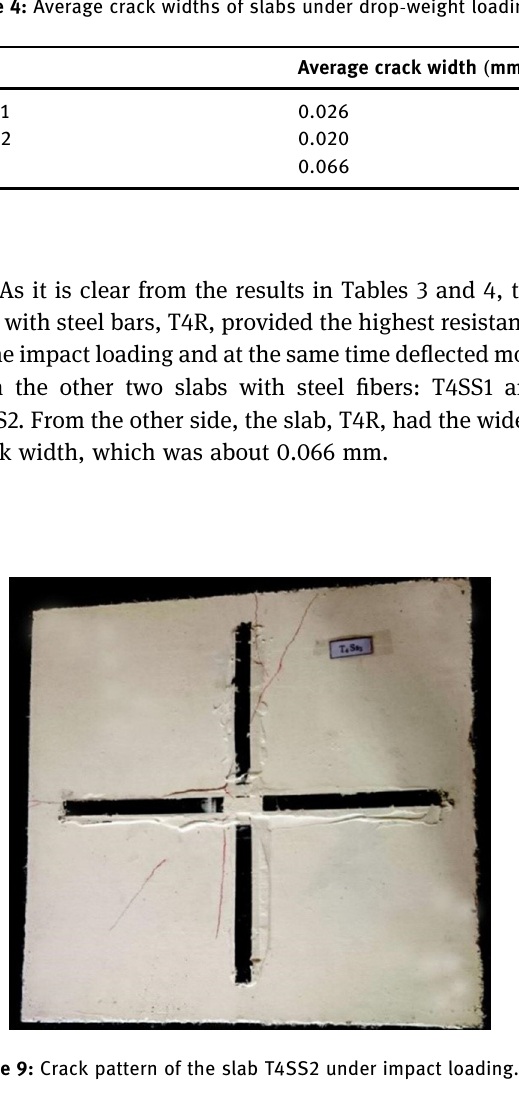
Table 4: Average crack widths of slabs under drop - weight loading